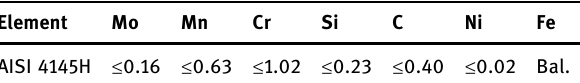
Table 1: Chemical composition of AISI 4145H steel ( wt% )